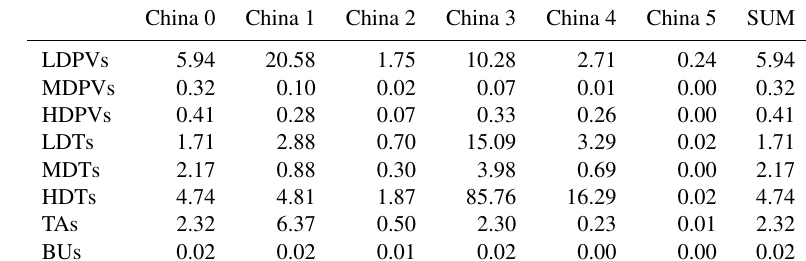
Table 5. IVOC tailpipe emissions by vehicle type and by emission control technology in China in 2015 (Gg). China 0